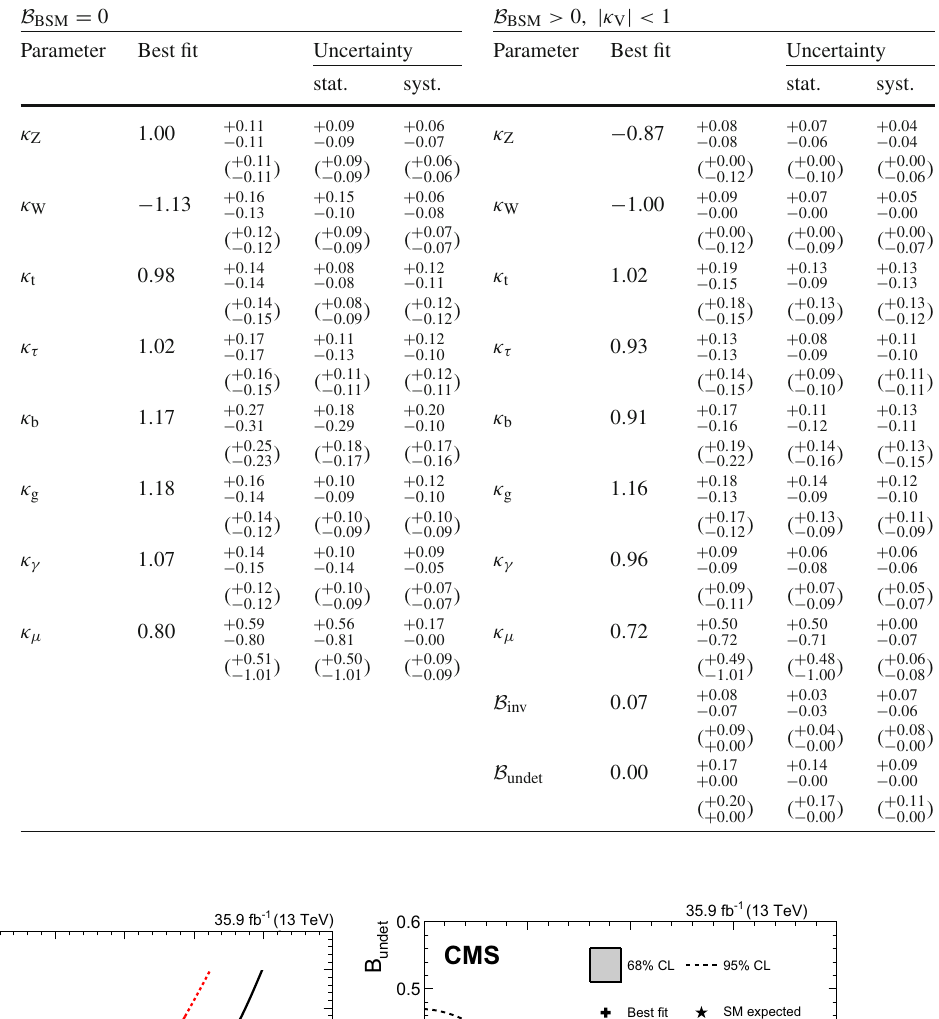
Table 8 Best fit values and ± 1 σ uncertainties for the parameters of the κ -framework model with effective loops. The expected uncertainties are given